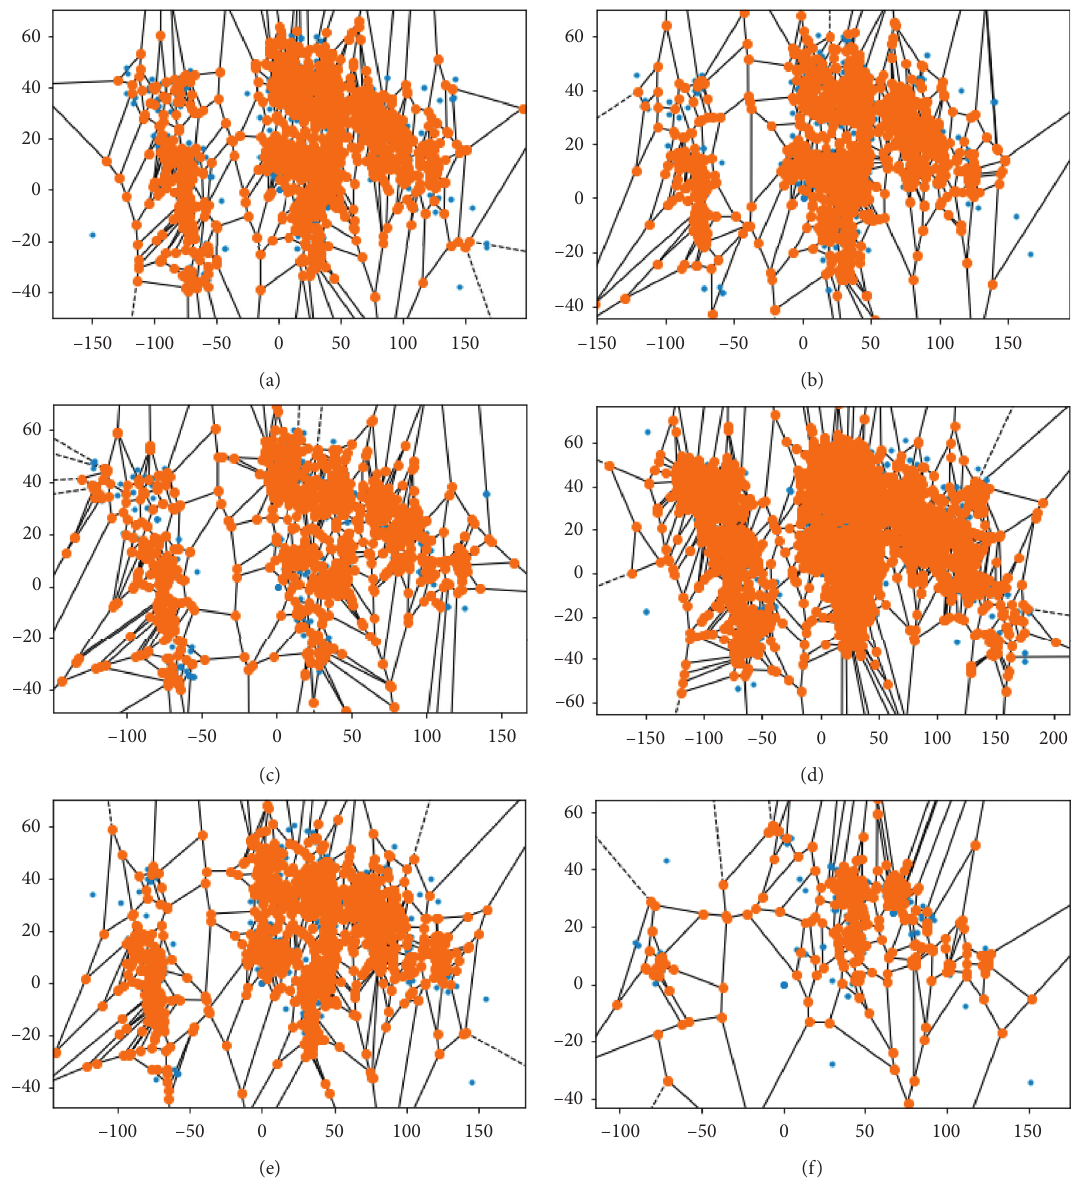
Figure 6: The Voronoi diagrams of extracted skeleton networks from different methods: (a) disparity filter, (b) global weight thresholding, (c) k-core decomposition, (d) minimum spanning tree, (e) w-skeleton, and (f)